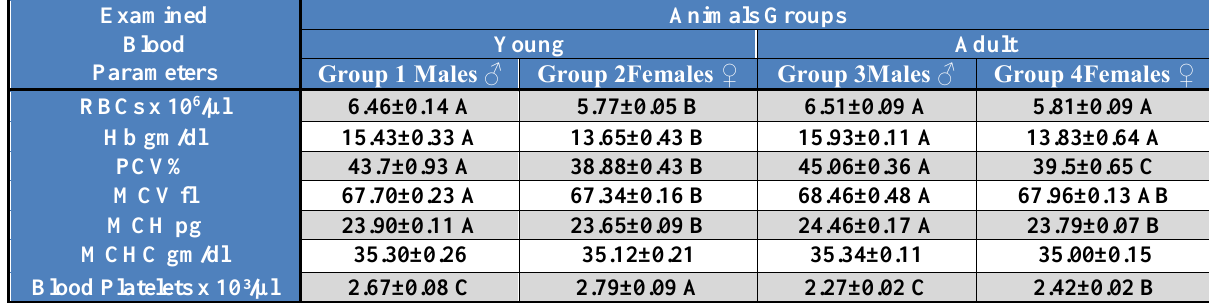
Table, 1: The results of RBCs count cell x10 6 /µl, related red blood corpuscle values, and blood platelets count cell x10³/µl in four groups of vervet monkeys, (M±S.E.)